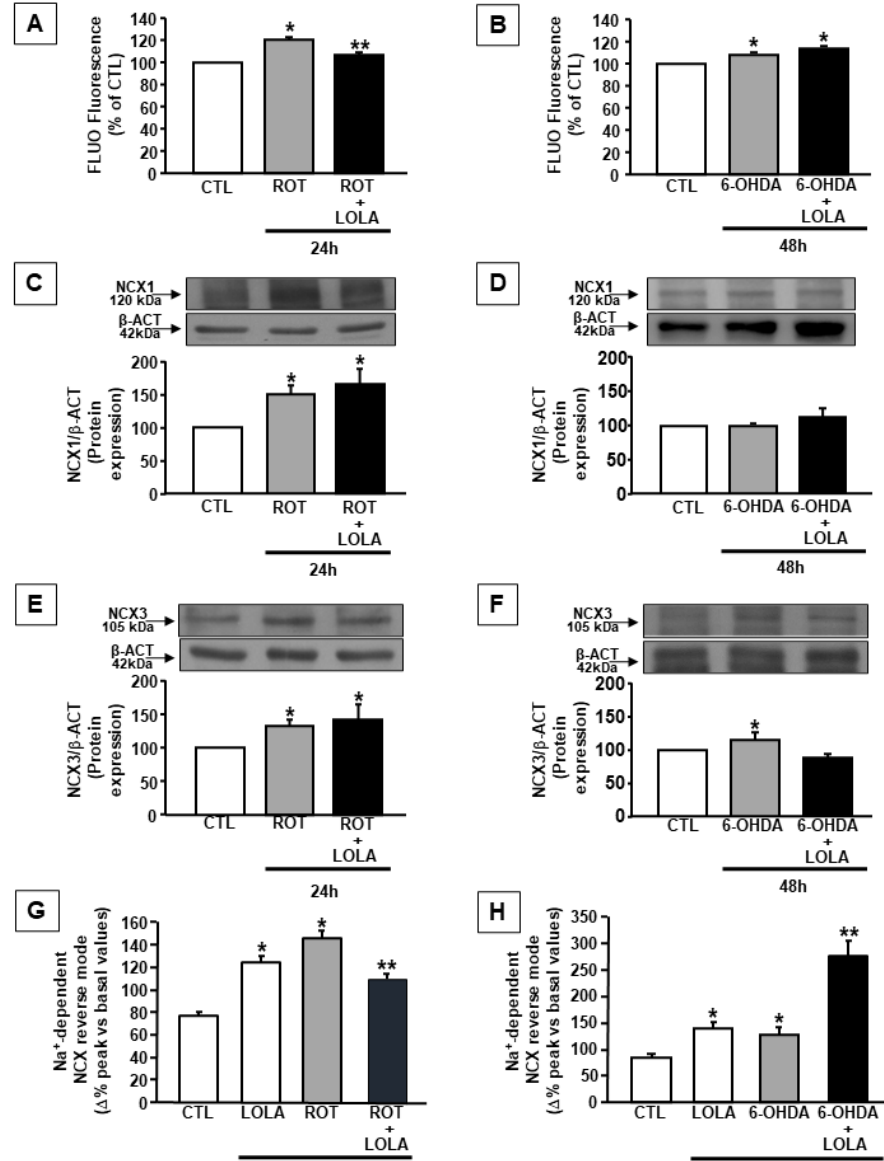
Figure 3. [Ca 2+ ] c and NCXs expression and activity in SH-SY5Y cells exposed to ROT and 6-OHDA in the presence and in the absence of LOLA: ( A ) Quantification of [Ca 2+ ] c in cells treated with ROT (500 nM/24 h) and ROT+LOLA (5 mM/24 h). * p < 0.05 vs. CTL; ** p < 0.05 vs. ROT. ( B ) Quantification of [Ca 2+ ] c in cells treated with 6-OHDA (30 μ M/48 h) and 6-OHDA+LOLA. * p < 0.05 vs. CTL. ( C ) NCX1 expression in SH-SY5Y cells treated with ROT and ROT+LOLA and ( D ) with 6-OHDA and 6-OHDA+LOLA; * p < 0.05 vs. CTL. ( E ) NCX3 expression in cells treated with ROT and ROT+LOLA and ( F ) with 6-OHDA and 6-OHDA+LOLA. * p < 0.05 vs. CTL. ( G ) NCXs activity in cells treated with LOLA, ROT, and ROT+LOLA and ( H ) with LOLA, 6-OHDA, and 6-OHDA+LOLA, measured in at least 20 cells for each independent experiments. All experiments were performed in three different experimental sections. Each column represents the mean of the percentage ± SEM. * p < 0.05 vs. CTL, ** p < 0.05 vs. ROT or 6-OHDA.